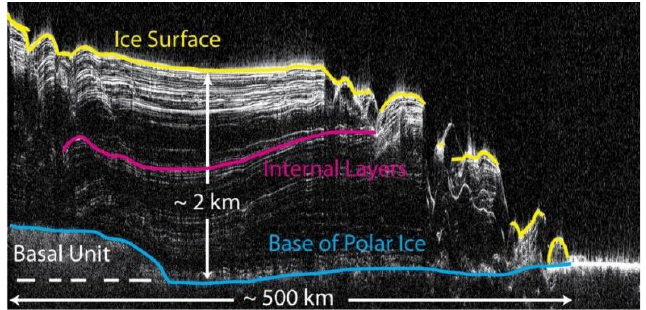
Figure 11. Cross-section of a portion of the north polar ice cap of Mars, derived from satellite radar sounding.